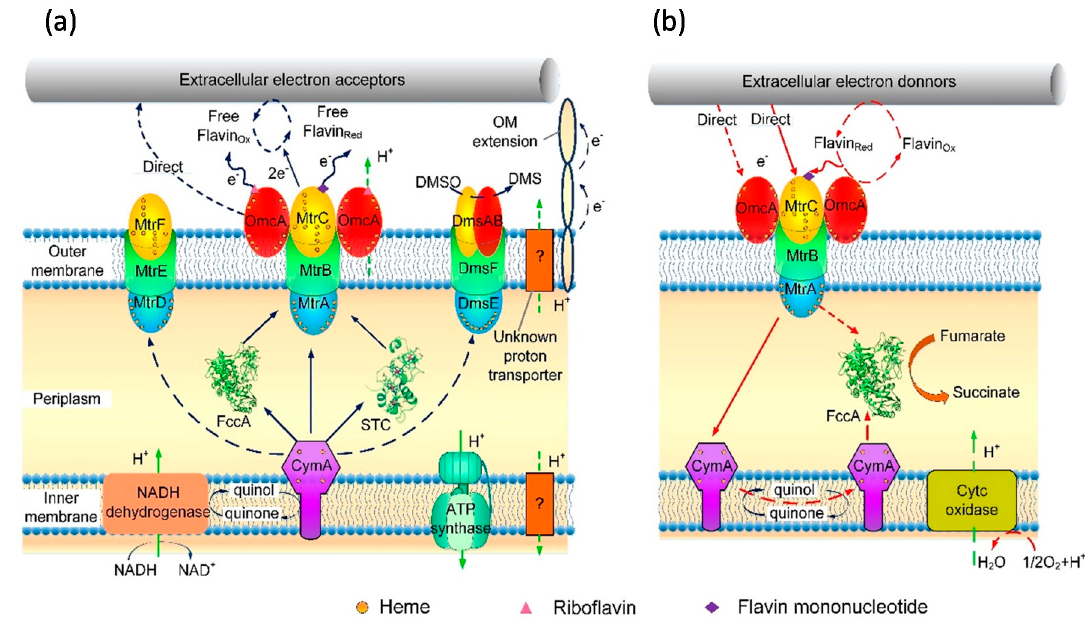
Figure 6. Conceptual model of the bidirectional EET pathways in S. oneidensis MR-1. The solid arrows indicate the verified electron flow path, and the dashed arrows indicate the possible electron flow. The blue arrows indicate the outward EET pathway, the red arrows indicate the inward EET pathway, and the green arrows indicate the H + flow pathway. ( a ) The outward EET toward extracellular acceptors utilizes the metal-reducing (Mtr) pathway. ( b ) The inward EET toward intracellular terminal reductase involves MtrCBA complex, periplasmic FccA, and inner membrane CymA. The cycle of oxidation (Ox) and reduction (Red) states of self-secreted flavins mediated both outward and inward EET. DMSO, dimethyl sulphoxide; Omc, outer-membrane cytochrome. Reprinted with the permission from ref [220]. Copyright (2020), Taylor & Francis.